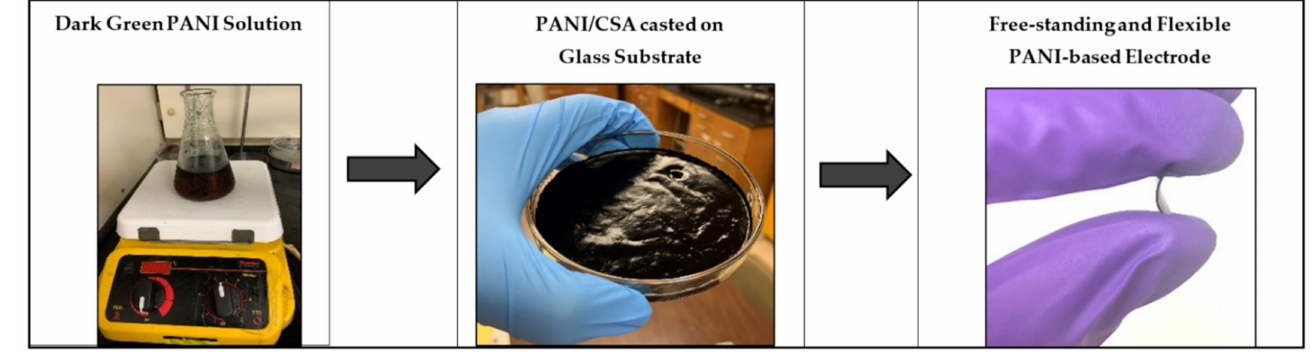
Figure 1. Optical images of the fabrication of flexible and free-standing PANI/CSA